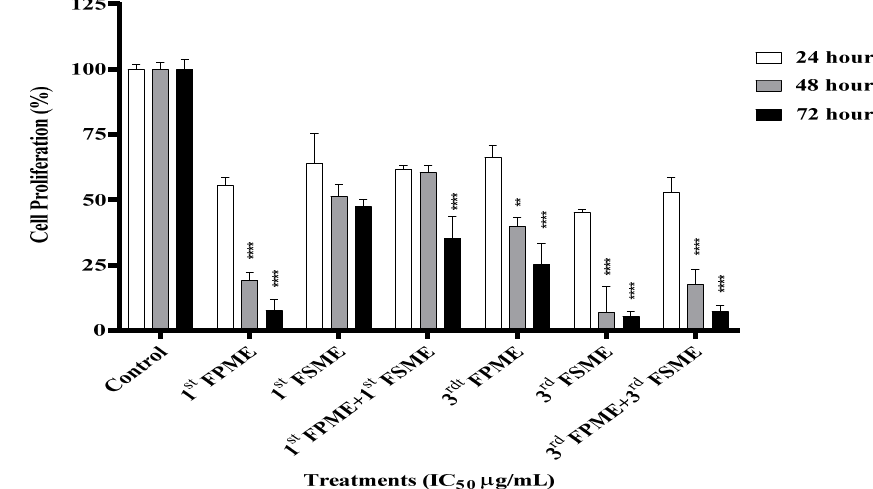
Figure 3. Fenugreek-inhibited cell proliferation of MCF-7 human breast cancer cells. The proliferation of cells was analysed using a cell proliferation assay. 1st Fenugreek Sprouts Methanol Extraction [1st FPME], 3rd Fenugreek Sprouts Methanol Extraction [3rd FPME], 1st Fenugreek Seeds Methanol Extraction [1st FSME], 3rd Fenugreek Seeds Methanol Extraction [3rd FSME]. The IC 50 treatment of the 3rd FSME at 5605 µ g/mL, 1st FPME at 812 µ g/mL, 3rd FSME at 1400 µ g/mL, and 3rd FPME at 526 µ g/mL for 24, 48, and 72 h decreased the proliferation of the MCF-7 cells in a time-dependent manner. The values are presented as means n = 6 ± SEM. The data were analysed using a one-way ANOVA test. Different asterisks indicate significant differences between data in the same group (** p ≤ 0.01, and **** p ≤ 0.0001).